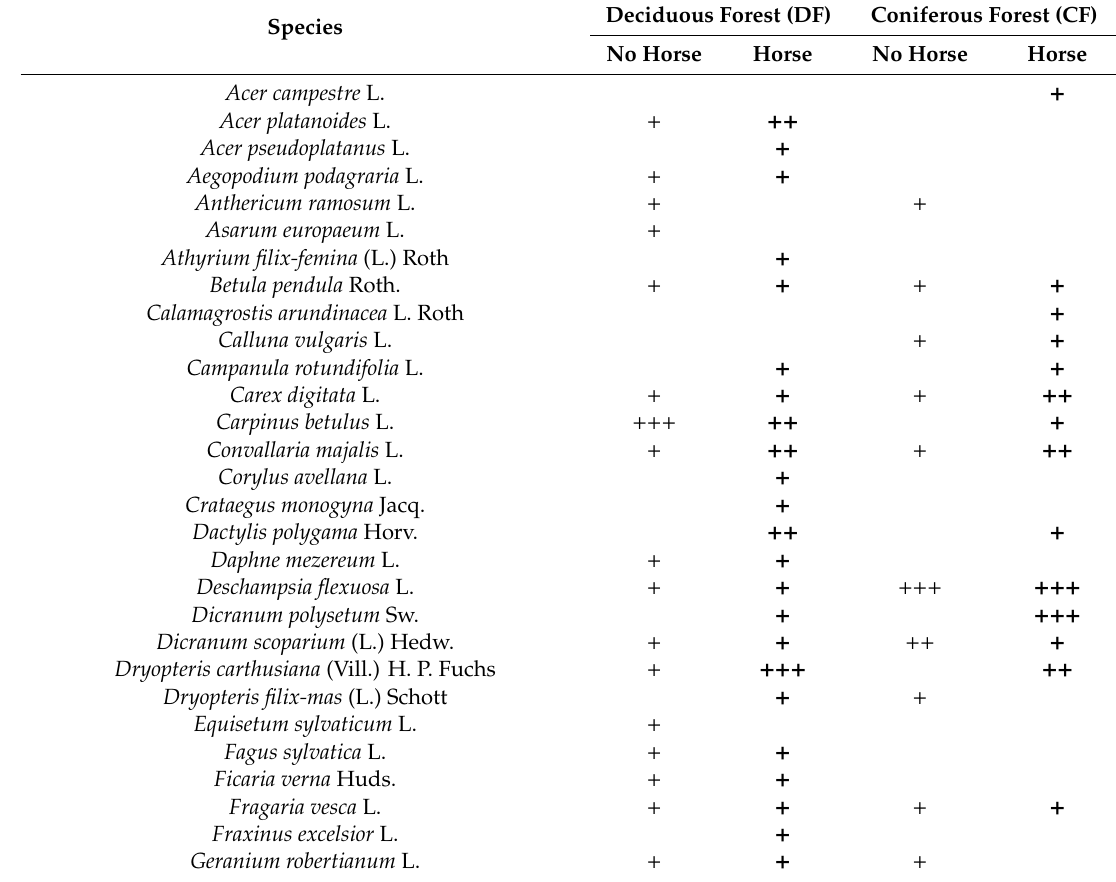
Table 1. The share of species in the herb layer and undergrowth lower 0.5 m in the areas of various fertility, with the presence or absence of the Polish primitive horse. The ‘ + ’ symbol denotes a percentage share of the entire number of existing species lower than 3%, the ++ symbol denotes the share between 3% and 6%, and the ‘ +++ ’ symbol denotes the number of the species exceeding 6%. The absence of the symbol means lack of the species. All species in the column account for 100%. Areas with horse were bold coded for ease of